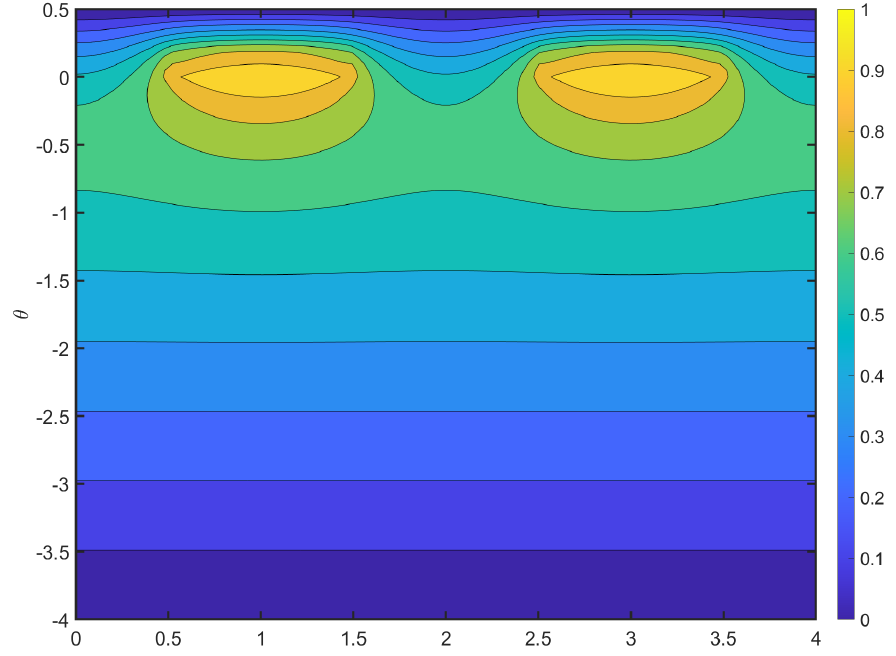
Figure 7. Temperature distribution in SAW with cooling at the initial steps of applying reso- nance power.